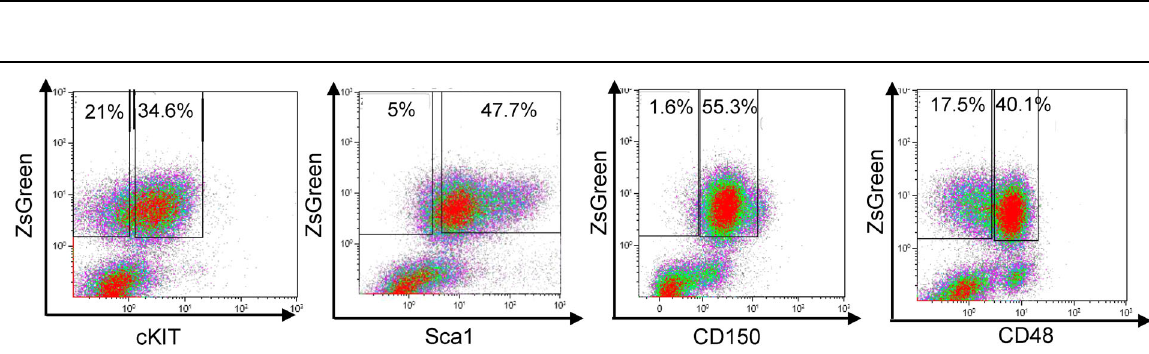
Fig. 5 Response of leukemia models to conventional chemotherapy. Four-week survival curves for untreated control mice, and chemo-treated mice (Fludarabine 25 mg/kg). a ML21 mice with lymphoid-leukemia; b ML23 mice with myeloid-leukemia. Per experiment n = 7 – 8 mice per treatment. Data shown are from one of three independent experiments.